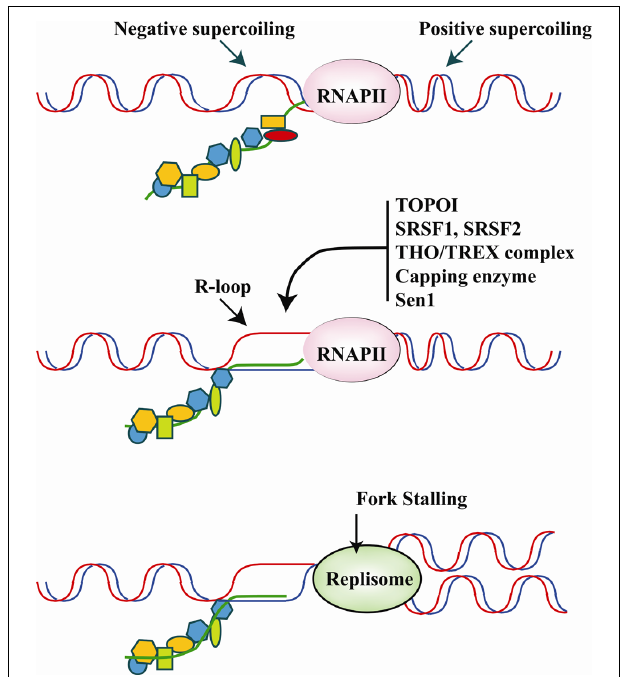
FIGURE 4 | Upper panel: the translocation of the transcriptional apparatus along the DNA induces positive and negative supercoiling, respectively, in front of and behind RNAPII. The physiological association of RBPs with the pre-mRNA molecule as it emerges from the transcriptional machinery is believed to play a major role in counteracting R-loop formation in negatively super-coiled regions. Middle panel: hybridization of the nascent RNA with the DNA template results in the formation of R-loops and occurs upon down-regulation, inhibition or mutation of several specific RBPs involved in different steps of pre-mRNA synthesis/maturation.The list of RBPs that may influence R-loop formation includes Capping enzymes, splicing factors SRSF1 and SRSF2, the THO/TREX complex, and Sen1/senataxin which is important for transcription termination. Moreover, DNA topoisomerase I (Topo I) by relieving torsional stress and phosphorylating SRSF1 can prevent R-loop formation. Bottom panel: R-loops hamper the movement of the DNA replication fork, which promotes genome instability.Thus, RBPs may be crucial to genome stability programs by inhibiting R-loop